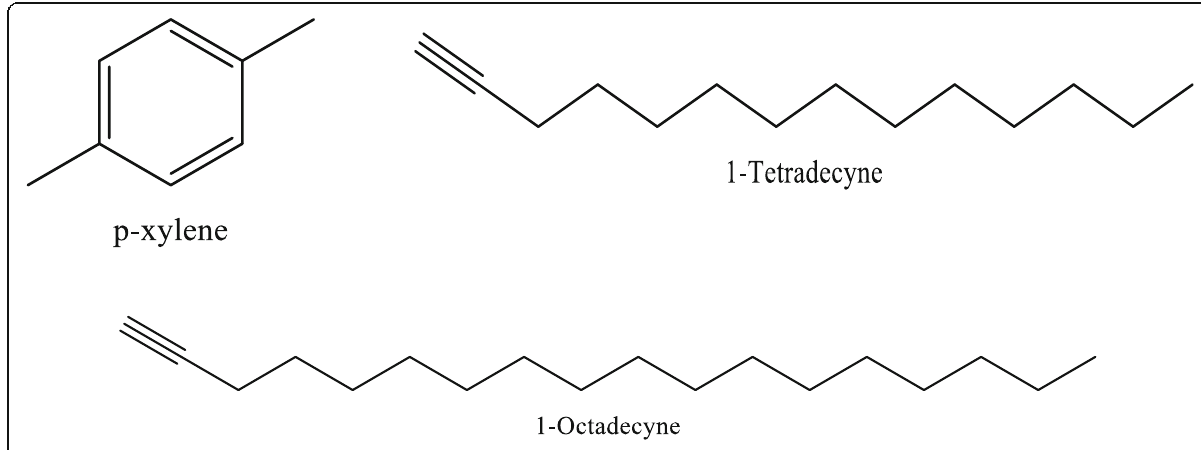
Fig. 19 Chemical structures of some alkynes isolated from A. vera and A. ferox